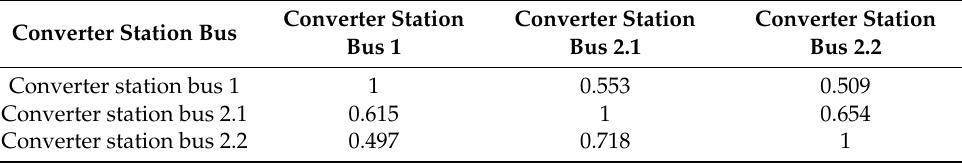
Table A3. The MIIF of converter station buses with Area 2 to be